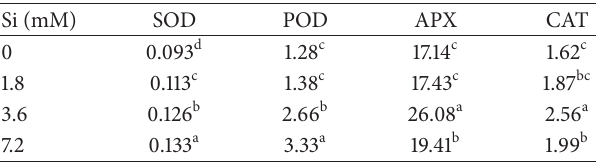
Data represent mean of six independent measurements. Means within a column followed by the same letters are not significantly different ( 𝑃 ≤ 0.05